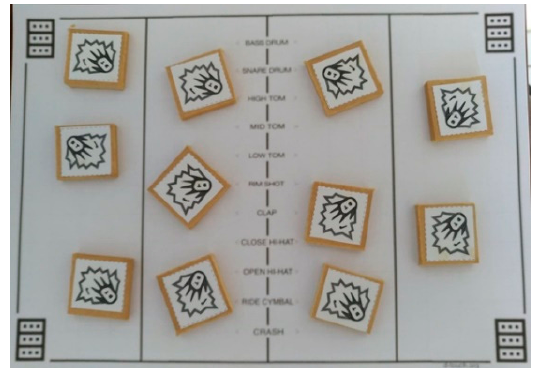
Figure 4. The drum machine’s customised physical components.